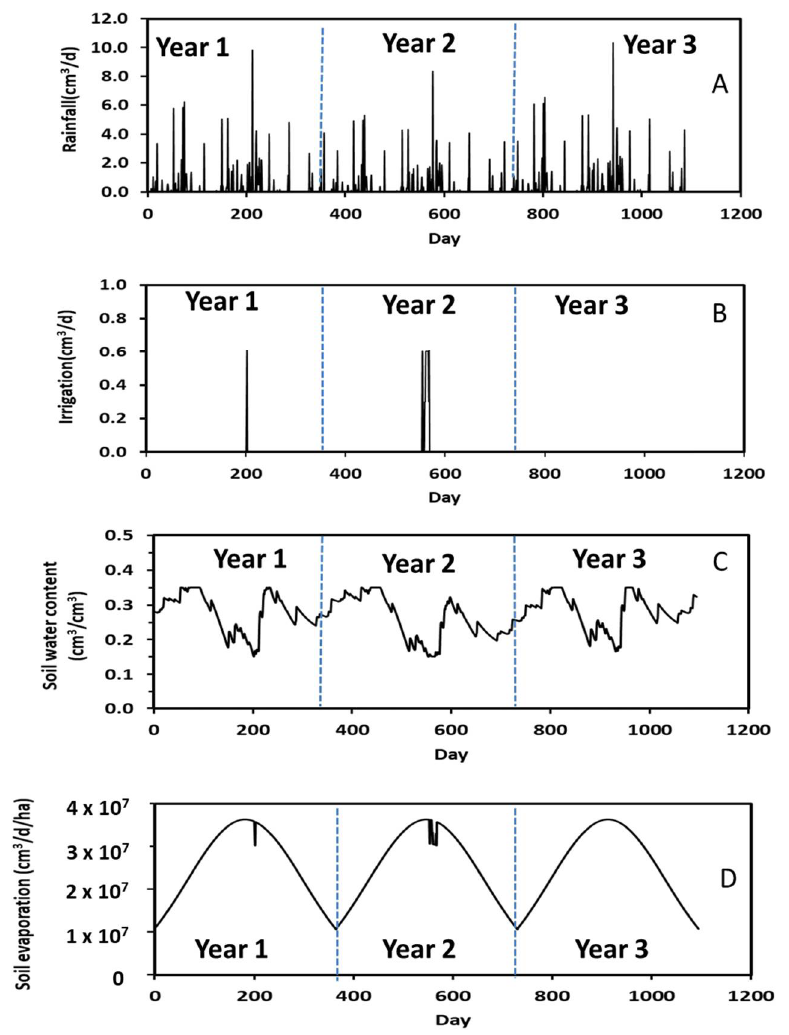
Figure 5. Measured daily rainfall along with simulated irrigation, water content, and soil evaporation during the 3-year period.